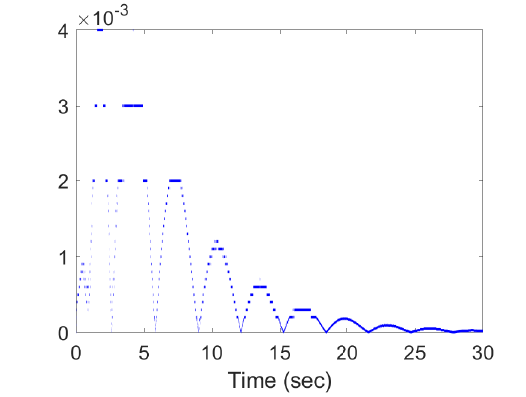
Figure 8. The trajectory of j u ( t ) .